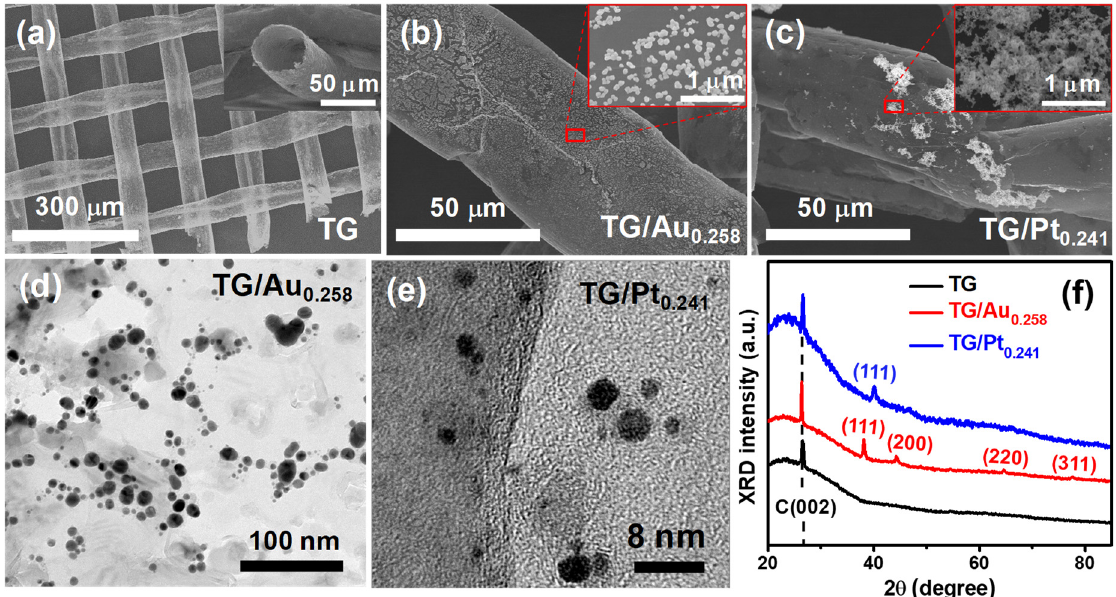
Figure 1. ( a ) SEM image of a TG mesh and a magnified graphene tube in the inset; ( b , c ) SEM images of the TG/Au 0.258 and TG/Pt 0.241 , respectively; ( d , e ) Corresponding TEM images of ( b , c ), respectively. ( f ) XRD patterns of the TG, TG/Au 0.258 , and TG/Pt 0.241 .